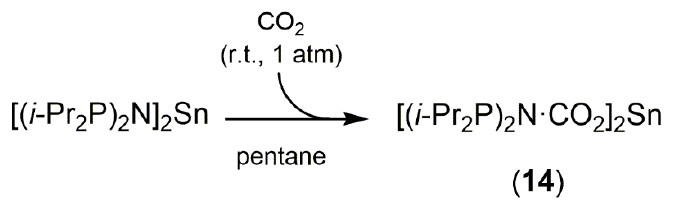
Scheme 21. Reaction scheme leading to Compound 14, data from [69].